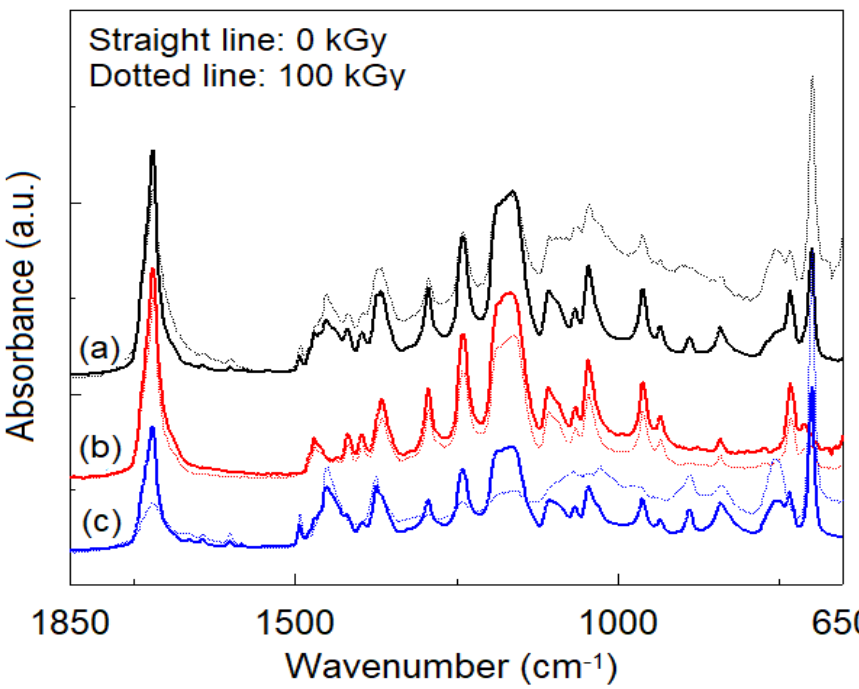
Figure 12. ATR/FTIR spectra recorded on non-irradiated and irradiated at 100 kGy blends: (a) SIS:PCL = 1:1; (b) SIS:PCL = 1:3; (c) SIS:PCL = 3:1.